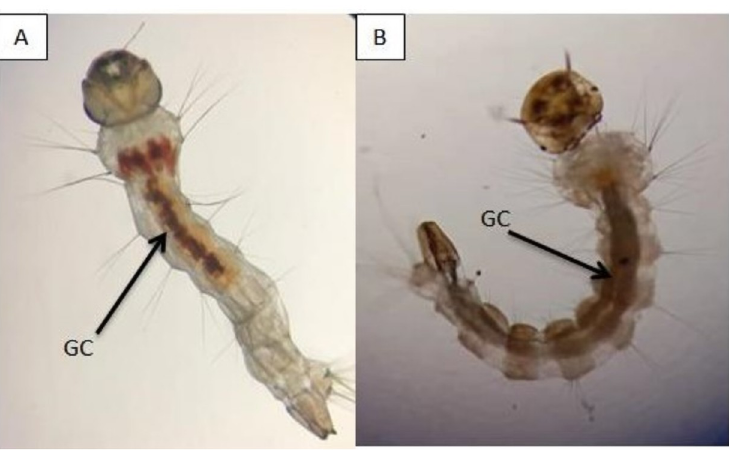
Fig 3. Morphology of Aedes mosquito midgut after exposure to Areca catechu nut extract. (A) Aedes aegypti larvae. (B) Aedes albopictus larvae . Note: Arrow indicates the plant extract (reddish-brown colour) present in the midgut; GC: gut content (after 24 hours).